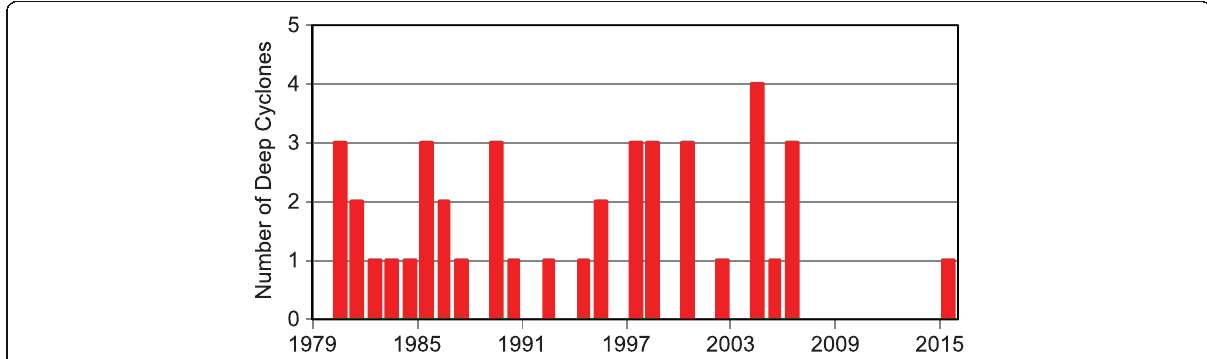
Fig. 8 Annual number of deep cyclones with sea surface atmospheric pressure in its center less than 980 hPa entering sector [45° N – 50° N 60° E – 90° E] that encompasses Central Asia according to ERA-interim reanalysis (Archive of Tilinina et al. 2013,